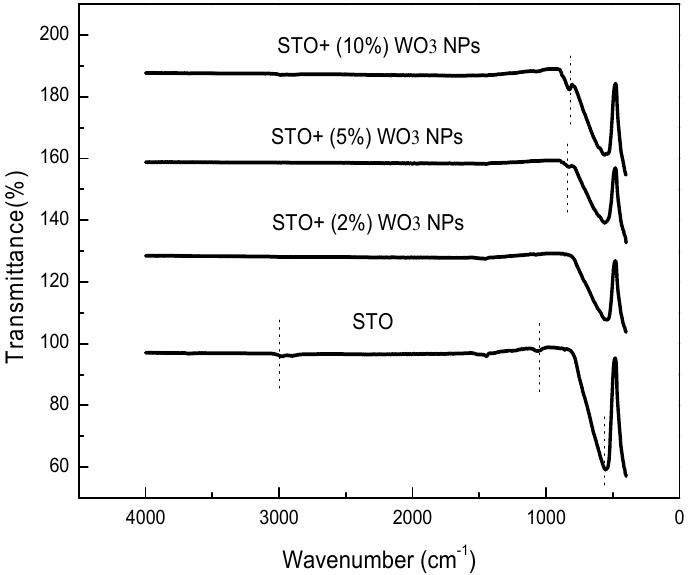
Figure 2. FT-IR results of STO ceramic and STO ceramic doped with x% of WO 3 NPs.